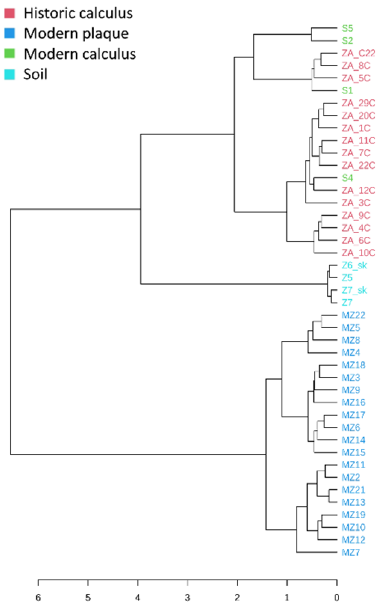
Figure 2. Species-level clustering dendrogram based on the Bray–Curtis index and Ward clustering algorithm. Samples with more similar species profiles were clustered closer together.